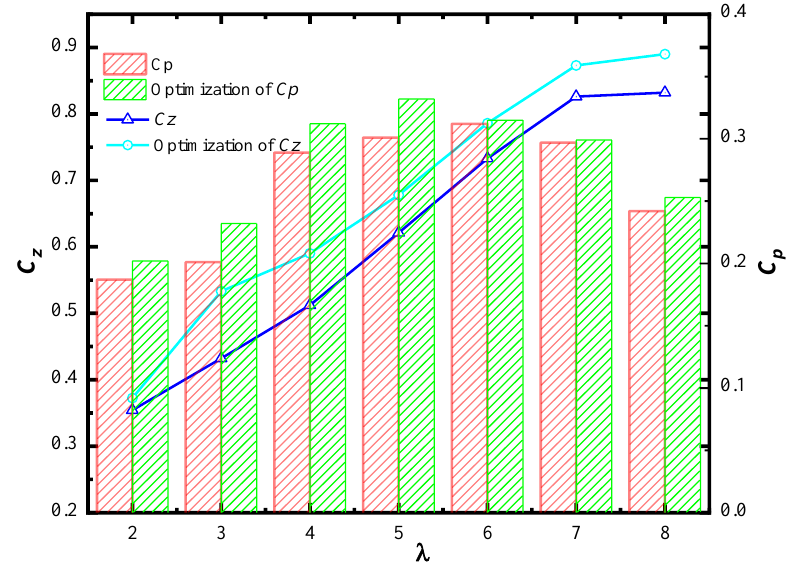
Figure 19. Optimization of C p and C z.